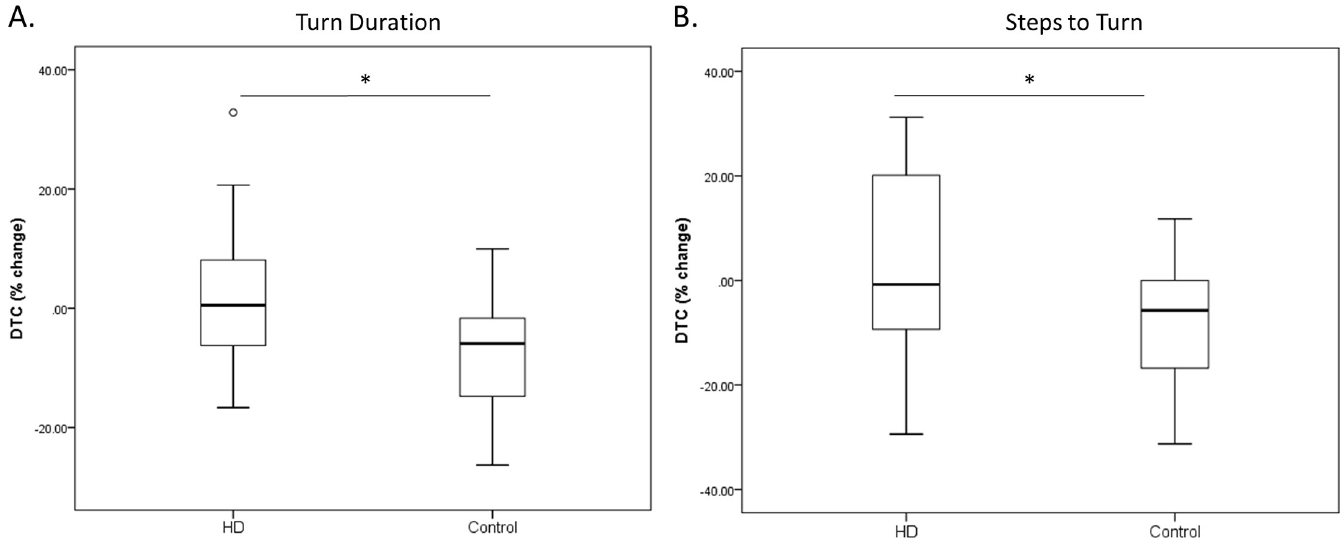
Fig 2. Dual-task costs while turning. Dual-task costs (DTC) of HD participants during turns; Results of a two-tailed independent sample t-test indicating significant cognitive interference observed for turn duration (p = 0.013) (A) and number of steps to turn (p = 0.029) (B) in HD compared to controls. Center line indicates the median value (50 th percentile), bottom line of the box represents the 25 th percentile, top line of the box represents the 75 th percentile, and the whiskers represent the maximum and minimum values, with the exception of one outlier in the HD group for turn duration. DTC calculated as ((DT-ST)/ST) � 100. � p < 0.05.